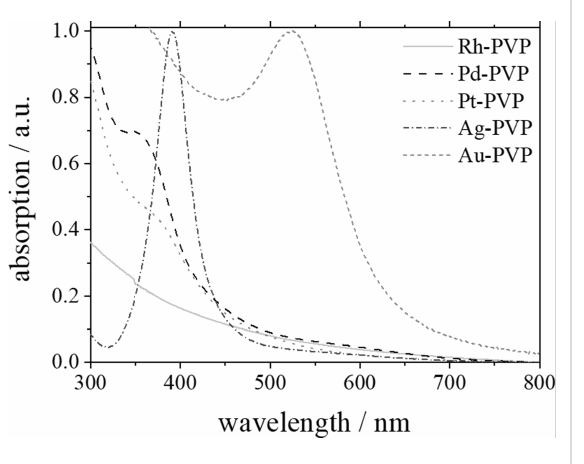
Figure 5: UV–vis absorption spectra of PVP-stabilized noble metal nanoparticles (Rh, Pd, Pt, Ag, Au). Conclusion